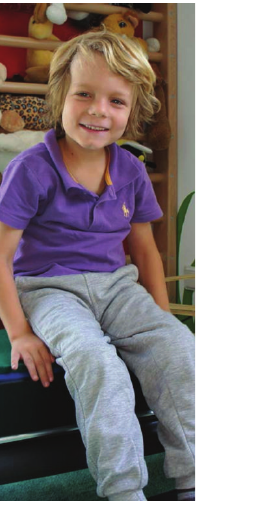
Figure 11: The success of autologous cord blood treatment in children with CP caused by hypoxic-ischemic encephalopathy depends on age. Recalculated from Lee et al., Table 1 [45], (HIE, 8/20, 65.2 ± 23.1 SD months, 𝑛 = 5 versus 37.3 ± 6.0 SD months, 𝑛 = 3 , ∗∗ 𝑃 < 0.01 , Chi-Square-test). The paper from which the data for recalculation were derived is available online at: